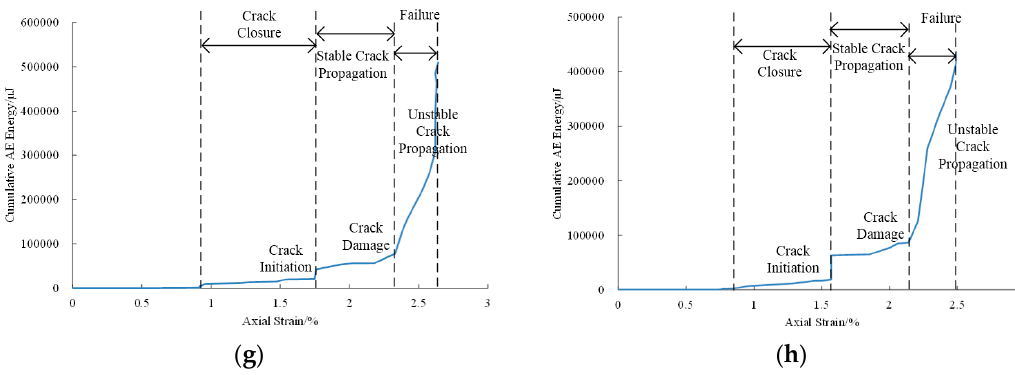
Figure 6. Variation of cumulative AE energy with axial strain: ( a )–( d ) are for parallel samples; ( e )–( h ) are for normal samples. ( a ) Temperature: 40 °C; Adsorption time: 20 days; ( b ) Temperature: 40 °C;